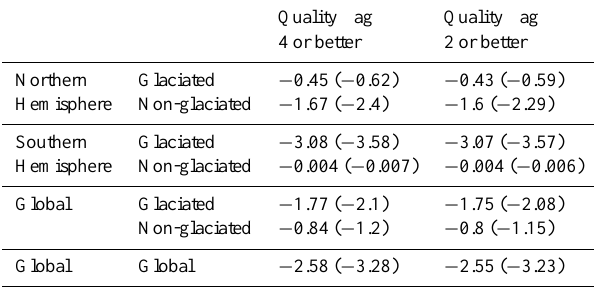
Table 3. All-sky (clear-sky) CrRE (Wm − 2 ) with different quality flag filters, derived using CAM4 kernels in all cases.